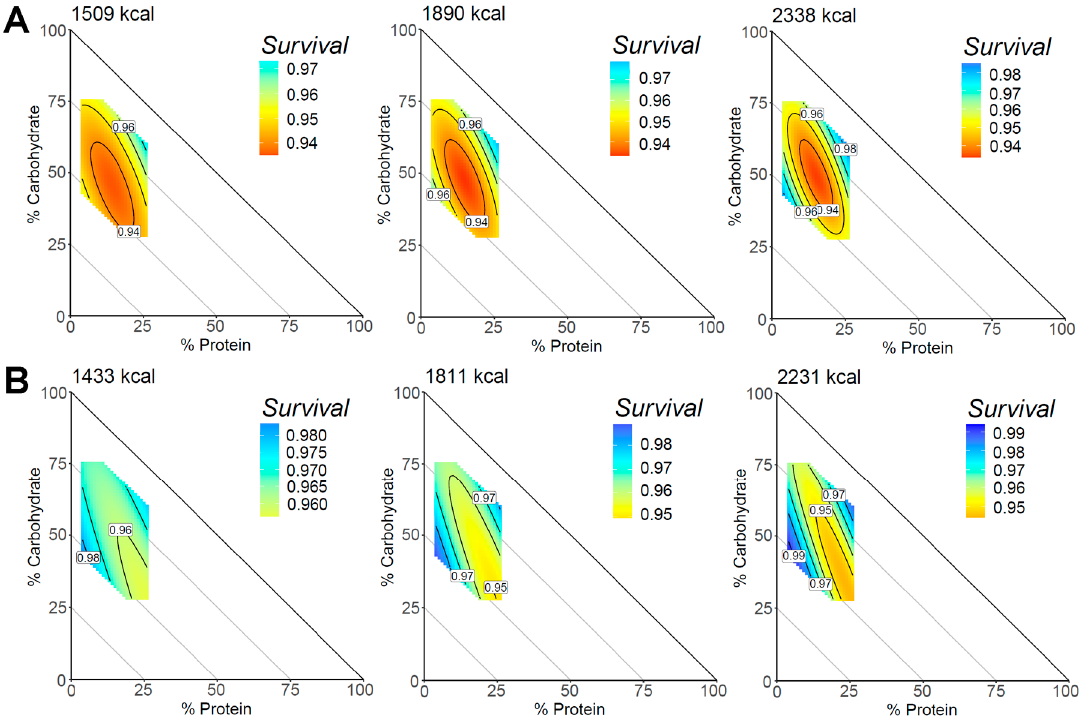
Figure 3. Associations of macronutrient composition with all-cause mortality for males and females. The mixture triangle shows the model predictions of the all-cause mortality survival score for the range of macronutrient percentages in this dataset. ( A ) The predictions using the 25th, 50th, and 75th percentiles of caloric intake for males, and ( B ) shows this for females. The x and y -axes show protein and carbohydrate levels, respectively. Percentage of fat can be inferred as decreasing and moving away from the origin such that each point on the triangle can be summed to equal 100%. Response values are colored such that warm colors show a higher risk of mortality and cooler colors show a lower mortality risk. Response surfaces were adjusted for age, sex, household income, BMI, physical activity, and Healthy Eating Index.